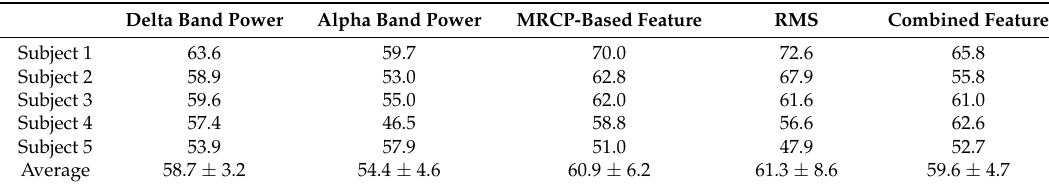
Table 4. Summarized results for five subjects k -nn (accuracy percentage).